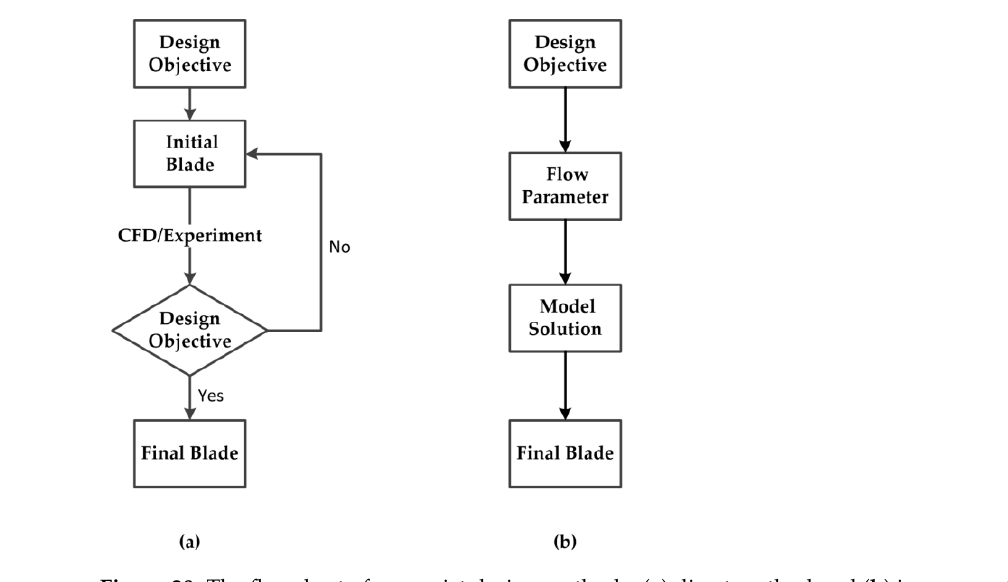
Figure 20. T he flowchart of pump-jet design methods: ( a ) direct method and ( b ) inverse method. Figure 20. The flowchart of pump-jet design methods: ( a ) direct method and ( b ) inverse